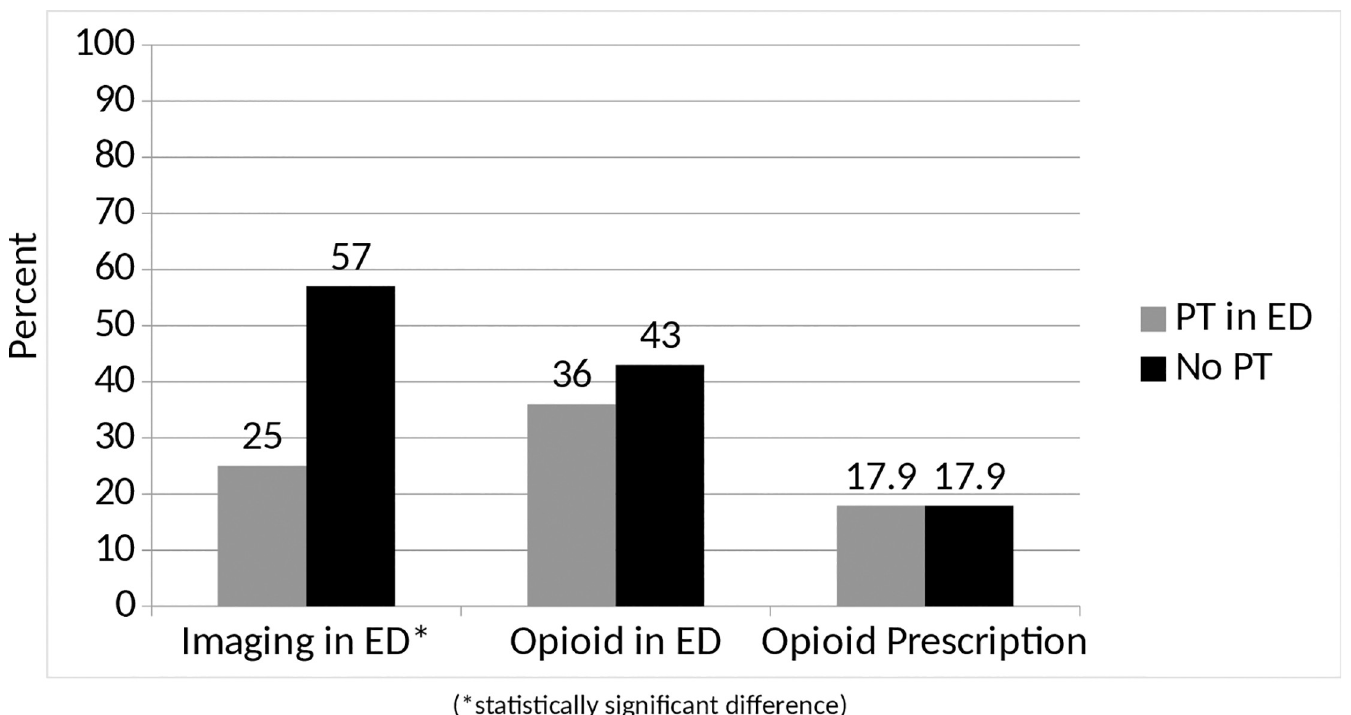
Fig 2. Subgroup comparison of matched patients with low back